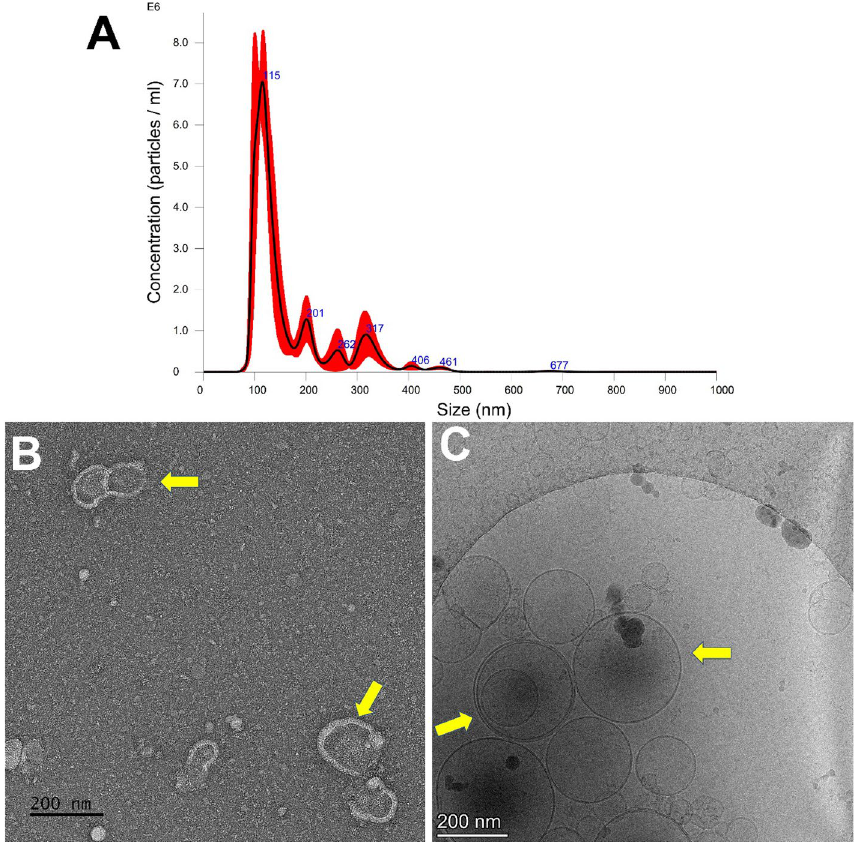
Figure 1. Isolation and characterization of VVs. VVs were isolated by the targeted nanofiltration method and were characterized using NanoSight nanoparticle tracking analysis and showed an average diameter of 158.6 ± 20.5 nm with a concentration of 1.1 × 10 8 particles/mL (dilution factor is 20 ×) ( A ). VVs were visualized by transmission electron microscopy ( B ), and cryo-transmission electron microscope ( C ) and showed bilipid vesicles (yellow arrows). The scale bar = 200